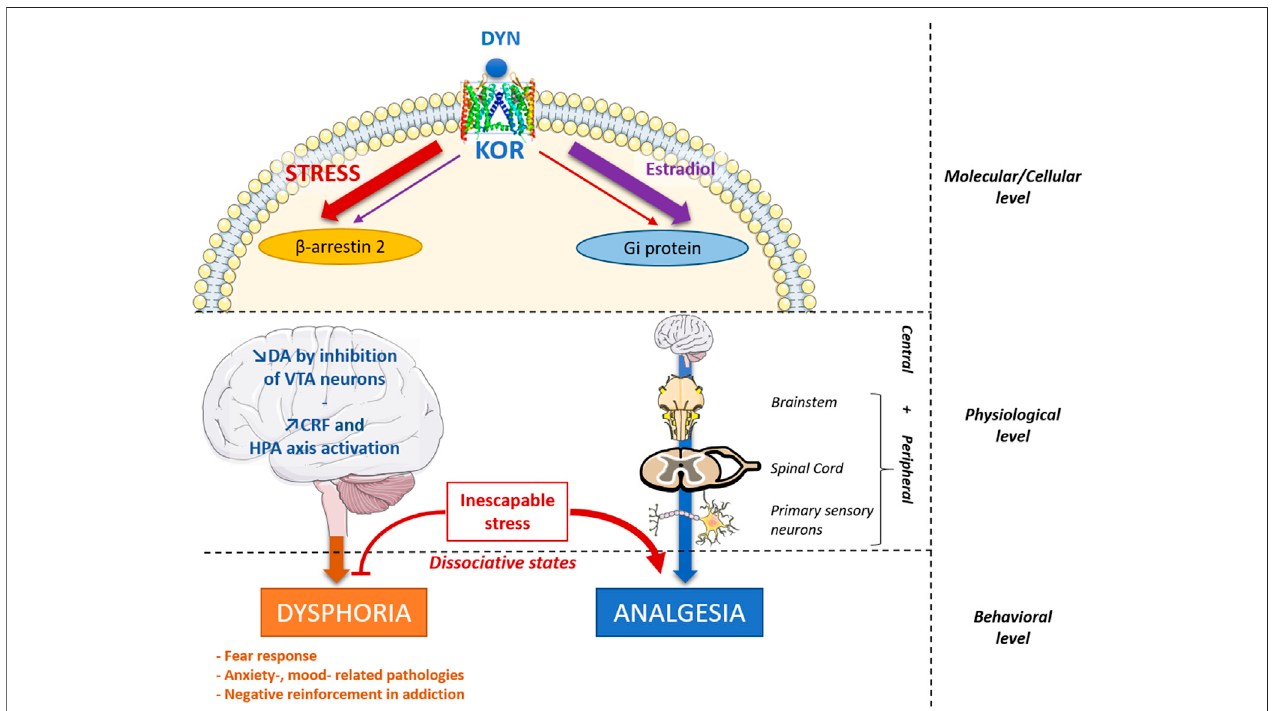
FIGURE 1 | Proposed integrative view of DYN/KOR system main effects and regulations. Dynorphin (DYN) is mainly released by stress and binds to KOR, which triggersits effectsthrough twosignaling pathways: the β -arrestin-2pathway and the Giprotein signaling pathway. Some compounds can create an imbalance between these two main effects, such as estradiol at the molecular level that decrease β -arrestin-2 signaling and increase Gi protein signaling (Abraham A. D. et al., 2018), promoting analgesic effects and decreasing dysphoric effects. Similarly, G-protein biased KOR agonists tend to promote analgesia without dysphoric side effects (Brust et al., 2016; Spetea et al., 2017) KOR also mediate central and peripheral analgesia, by acting on primary sensory neurons, the spinal cord and the brainstem. In turn,dysphoriceffectsarepotentiallyinducedthroughaDAreleasedecreaseinthebrainbyinhibitingtheVTAdopaminergicneuronsandbyanincreasedreleaseofCRF andHPAaxisactivation.Stress-inducedanalgesiaisKORdependentinthecaseofinescapablestress.Thismaysomehowberelatedtodissociativestates,followingan emotional shutdown, thought to involve KOR activation, increasing opioid dependent analgesia and producing alterations of mood and perception (Lanius et al., 2018). CRF, Corticotropin Releasing Factor; DA, dopamine; HPA axis, Hypothalamo-Pituitary-Adrenal axis; KOR, Kappa Opioid Receptor; VTA, ventral Tegmental